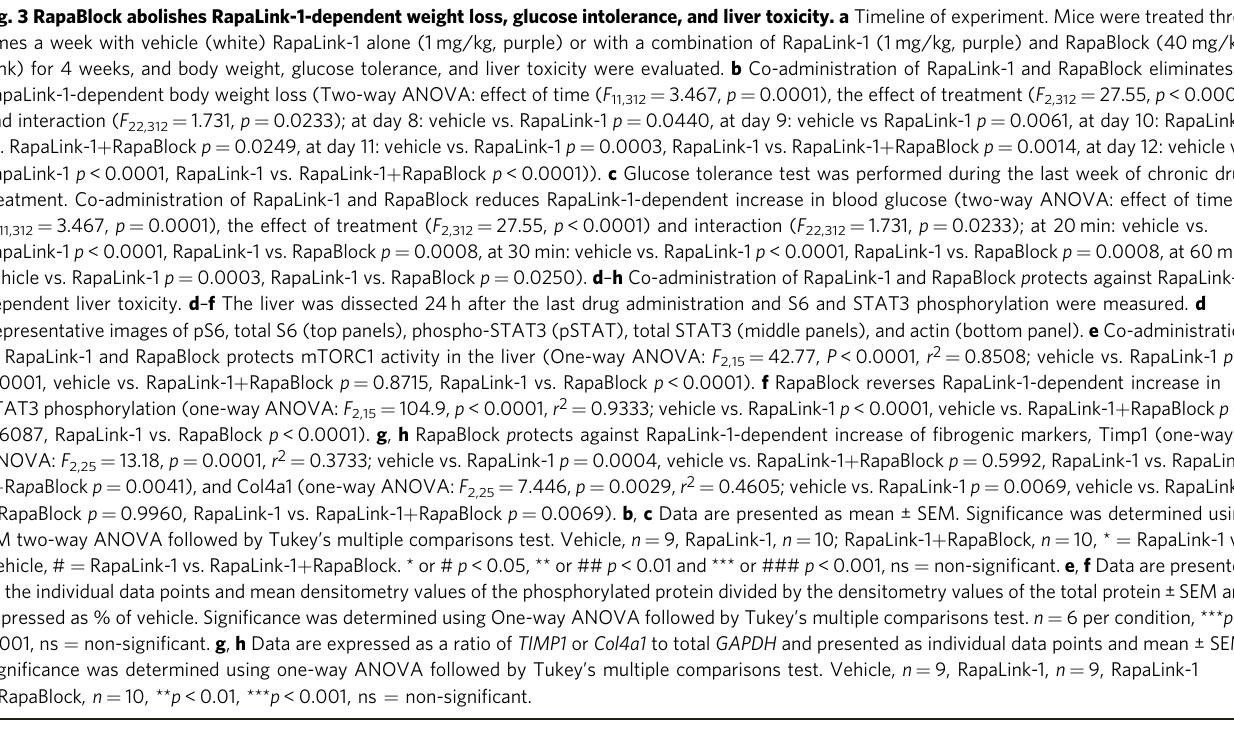
Fig. 3 RapaBlock abolishes RapaLink-1-dependent weight loss, glucose intolerance, and liver toxicity. a Timeline of experiment. Mice were treated three times a week with vehicle (white) RapaLink-1 alone (1 mg/kg, purple) or with a combination of RapaLink-1 (1 mg/kg, purple) and RapaBlock (40 mg/kg, pink) for 4 weeks, and body weight, glucose tolerance, and liver toxicity were evaluated. b Co-administration of RapaLink-1 and RapaBlock eliminates RapaLink-1-dependent body weight loss (Two-way ANOVA: effect of time ( F 11,312 = 3.467, p = 0.0001), the effect of treatment ( F 2,312 = 27.55, p < 0.0001) and interaction ( F 22,312 = 1.731, p = 0.0233); at day 8: vehicle vs. RapaLink-1 p = 0.0440, at day 9: vehicle vs RapaLink-1 p = 0.0061, at day 10: RapaLink-1 vs. RapaLink-1 + RapaBlock p = 0.0249, at day 11: vehicle vs. RapaLink-1 p = 0.0003, RapaLink-1 vs. RapaLink-1 + RapaBlock p = 0.0014, at day 12: vehicle vs. RapaLink-1 p < 0.0001, RapaLink-1 vs. RapaLink-1 + RapaBlock p < 0.0001)). c Glucose tolerance test was performed during the last week of chronic drug treatment. Co-administration of RapaLink-1 and RapaBlock reduces RapaLink-1-dependent increase in blood glucose (two-way ANOVA: effect of